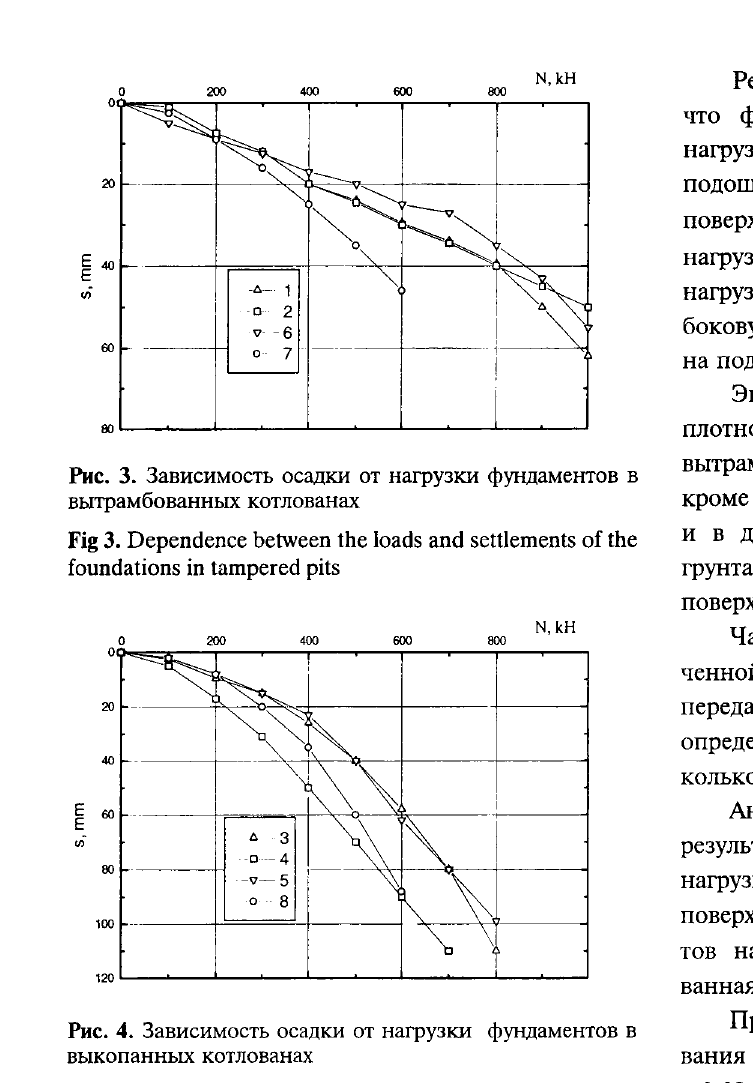
Fig 4. Dependence between the loads and settlements of the foundations in dug